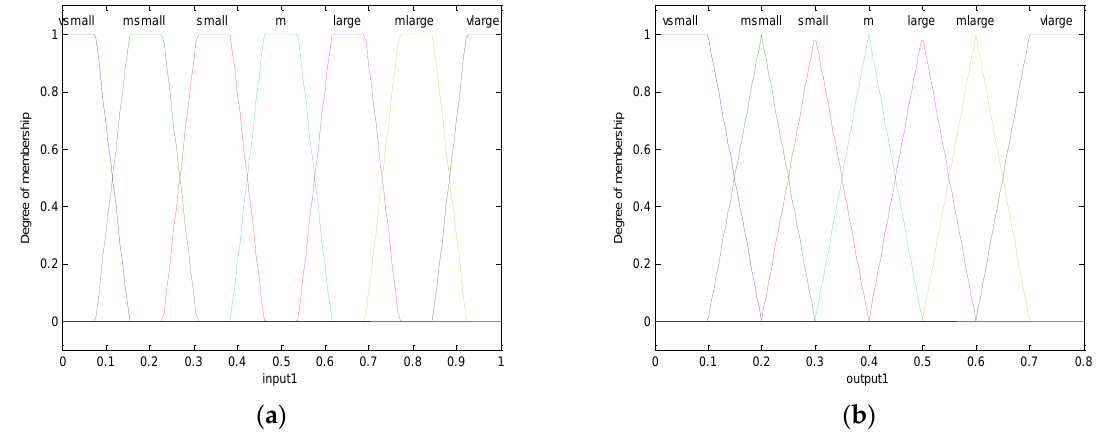
Figure 9. The membership functions of input ( a ) and output ( b ).